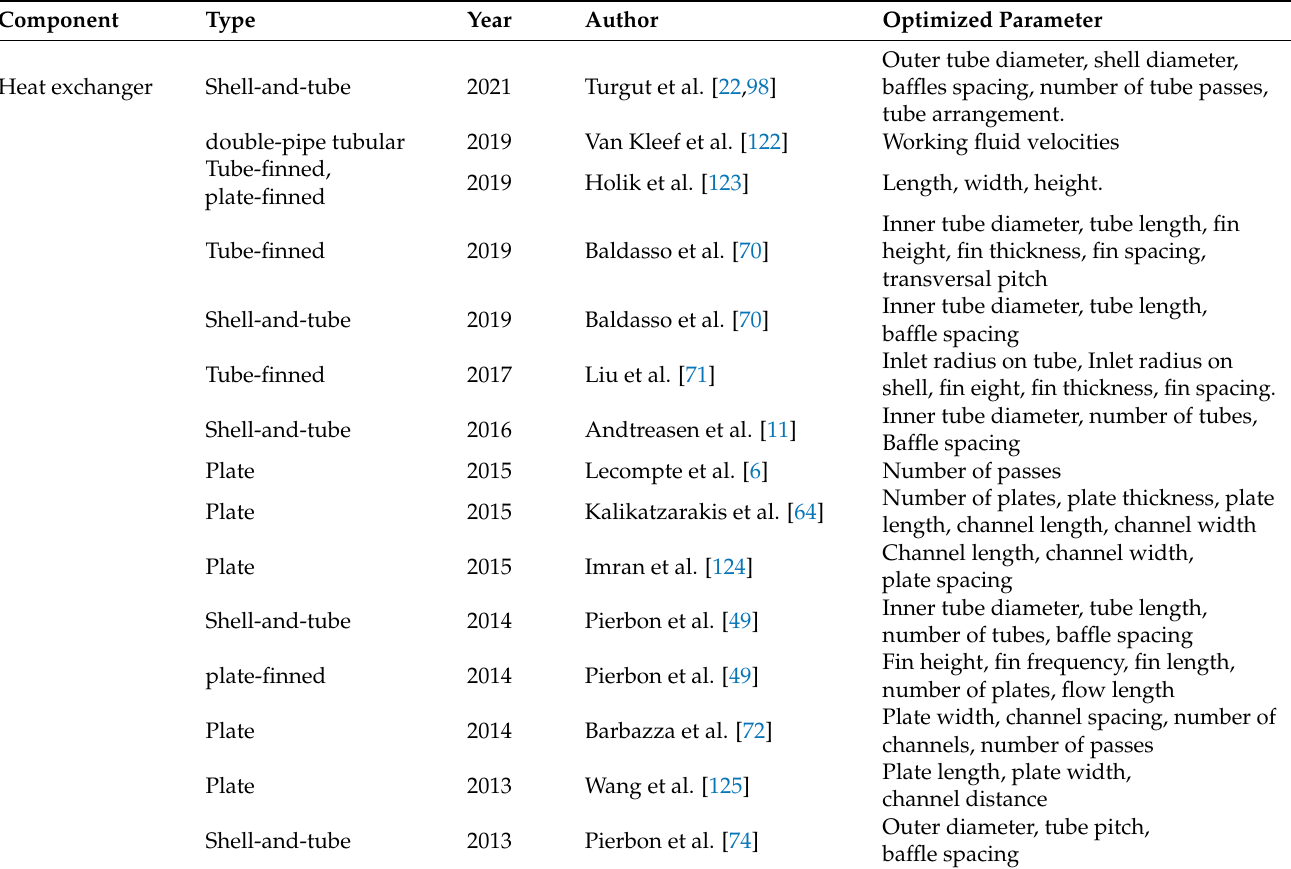
Figure 11. Type of expansion devices in ORC multi-objective optimization. Table 6. List of the reference focusing on the component